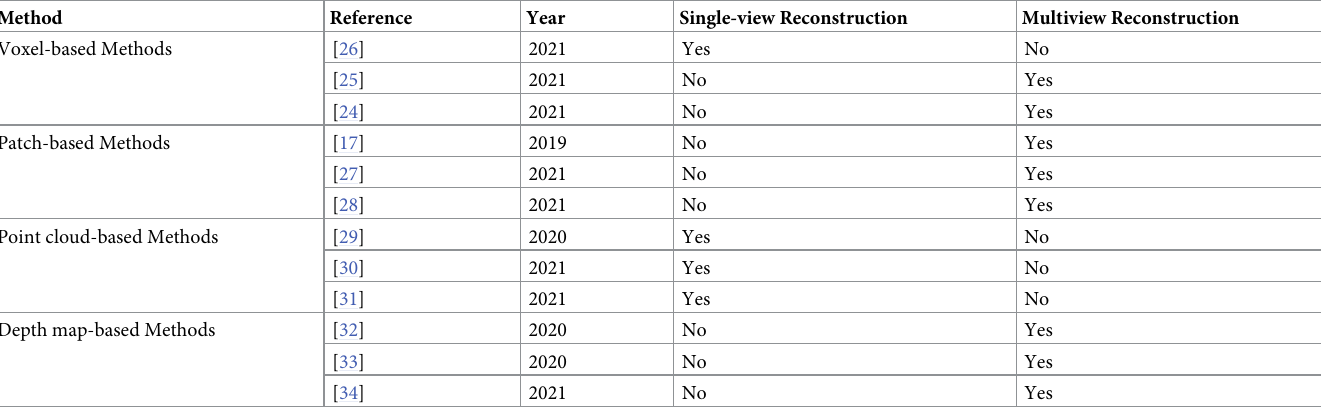
Table 1. Summary of recent methods for 3D